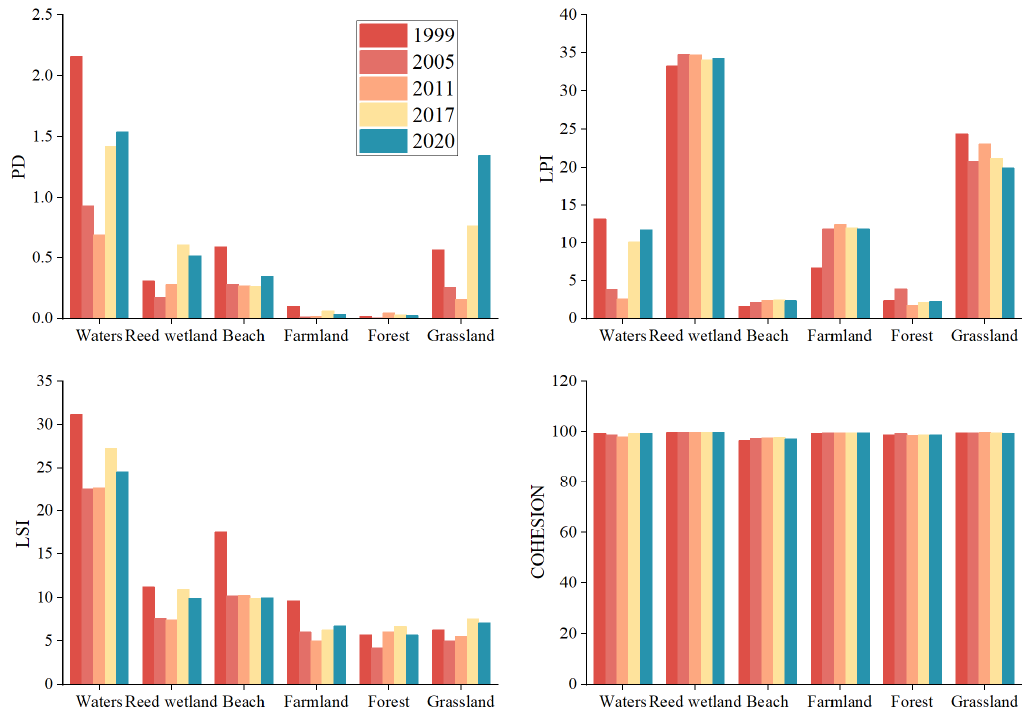
Figure 9. Changes in landscape indices of di ff erent wetland types from 1999 to 2020.